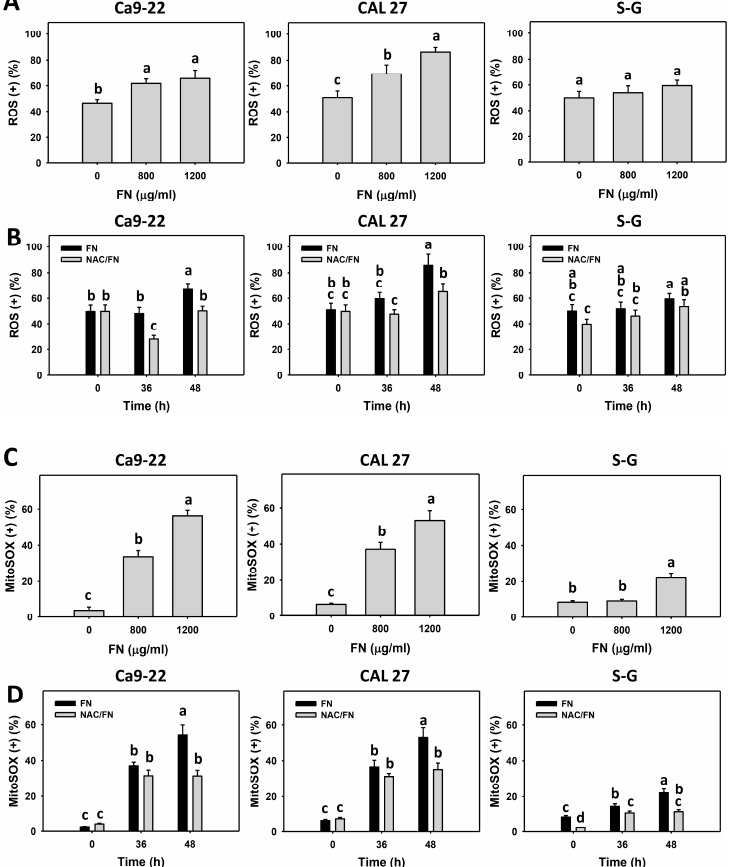
Figure 5. Fucoidan drives ROS and MitoSOX generation in oral cancer cells. Summary histograms of the flow cytometry results are presented. The individual density plots are presented in Supplementary Figure S2. ( A , C ) ROS and MitoSOX statistical analyses. Oral cancer (Ca9-22 and CAL 27) and non-malignant cells (S–G) were treated with fucoidan (control, 800, and 1200 μg/mL) for 0 and 48 h. (+) indicates high levels of ROS and MitoSOX. ( B , D ) The effect of oxidative stress on ROS and MitoSOX generation and the GSH depletion of fucoidan-incubated oral cancer cells. After NAC preincubation or not, cells were treated with fucoidan (1200 μg/mL) with NAC co-treatment (10 mM) for 0, 36, and 48 h. NAC/fucoidan (NAC/FN) represents the pretreatment with NAC and post-treatment with FN. Data = mean ± SD ( n = 3 experiments). Data with non-overlapping letters reveal significant differences ( p < 0.05). In the example of Figure 5D (Ca9-22 cells), FN at 0, 36, and 48 h, labeled with the connecting letters “c, b, and a”, has significant results, because the letters do not overlap. FN and NAC/FN at 48 h labeled with “a and b” have significant results. In contrast, FN and NAC/FN at 36 h labeled with “b” have nonsignificant results because they overlap with “b”. “d” is not appeared for statistic analysis in the example. The positive controls of ROS and MitoSOX are provided in Supplementary Figures S7 and